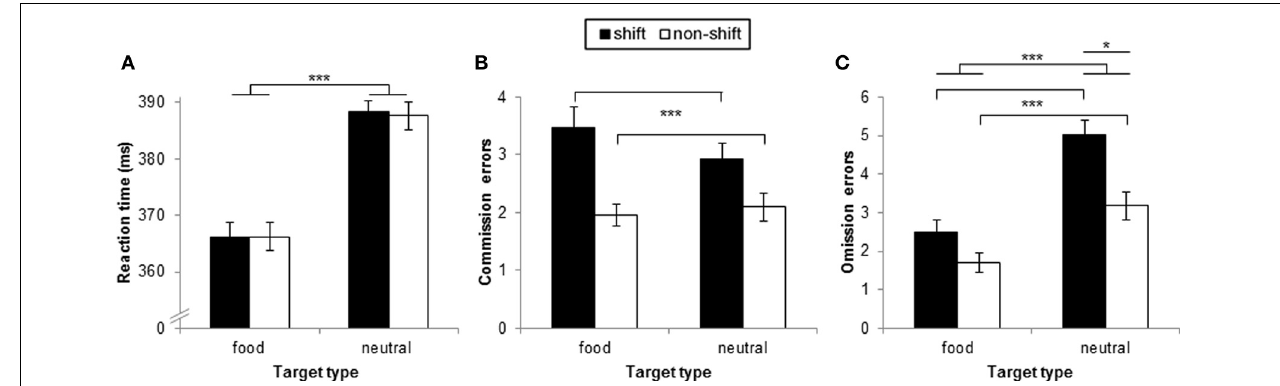
Table 3 | Pearson correlation coefficients between task performance and BMI, food deprivation, and questionnaire measures (study 1). Reaction times Commission errors Omission errors Food Neutral Food-neutral Food Neutral Food-neutral Food Neutral Food-neutral Food deprivation 0 . 17 0 . 07 0 . 17 − 0 . 19 − 0 . 00 − 0 . 15 0 . 02 0 . 04 − 0 . 02 0 . 13 0 . 26 − 0 . 15 0 . 18 − 0 . 17 0 . 19 0 . 12 0 . 12 0 . 26 − 0 . 17 PSRS − 0 . 01 − 0 . 01 − 0 . 00 − 0 . 10 0 . 27 − 0 . 29 * 0 . 11 0 . 15 − 0 . 07 BIS-15 − 0 . 14 − 0 . 04 − 0 . 16 0 .